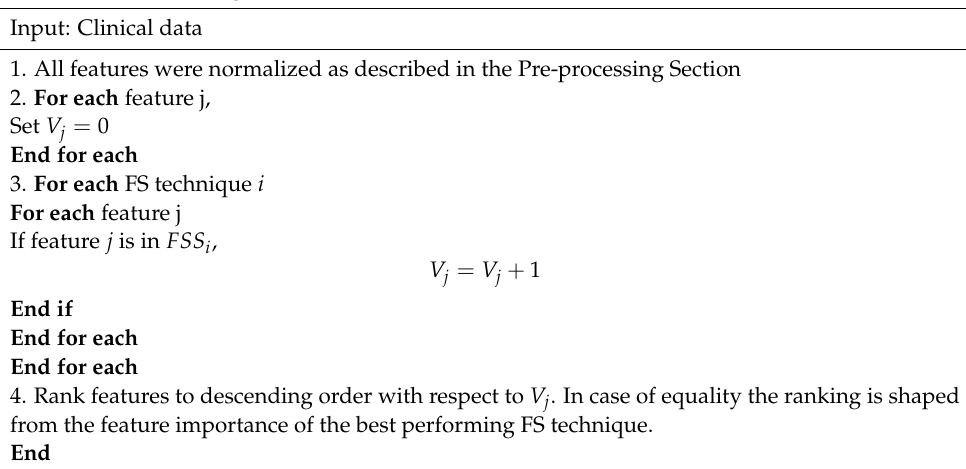
Algorithm 2 Pseudoalgorithm of the feature